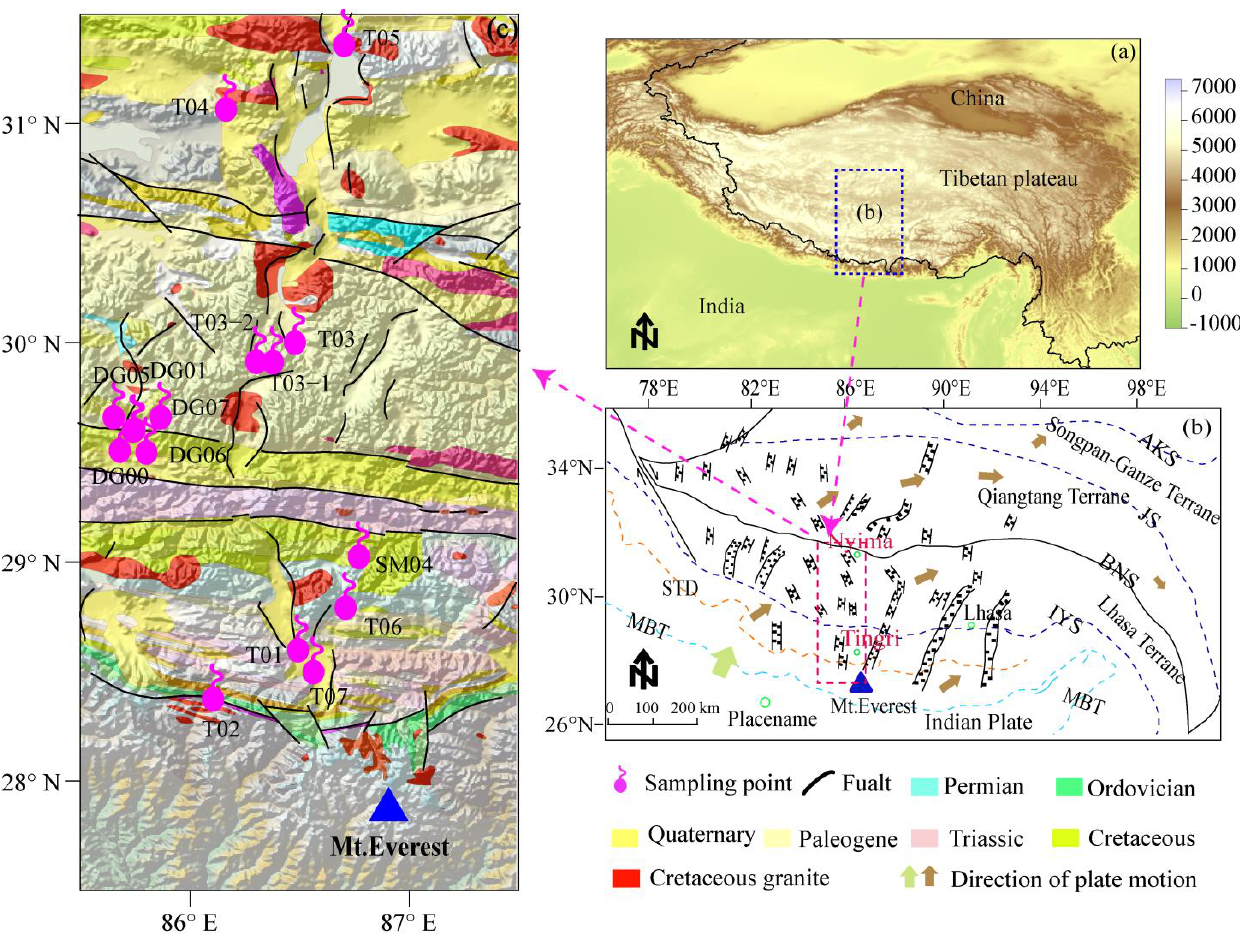
Figure 1. Distribution plot of sample sites: ( a ) Geographic location of the study area; ( b ) simplified map showing the tectonic framework of Tibet with N − S striking rifts adapted from Wang et al. [9]; Jinshajiang Suture Zone (JS), South Tibet Detachment (STD), Main Border Thrust Fault (MBT); ( c ) geological map and topographic map in the